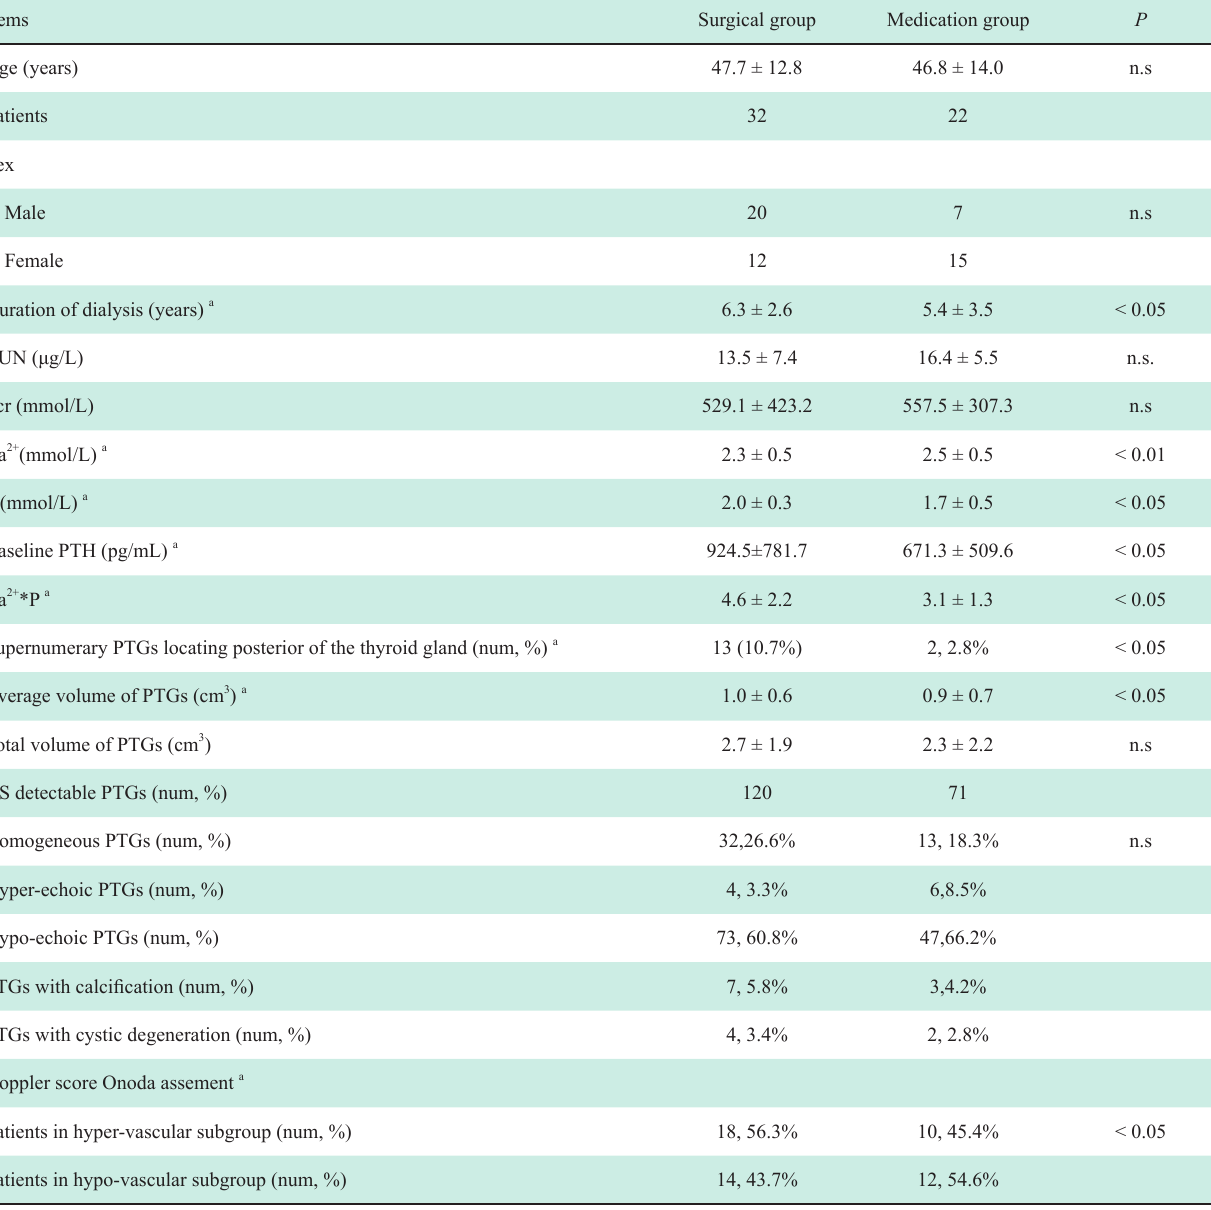
Table 2 Demographics and clinical features of patients in the surgical group and medication